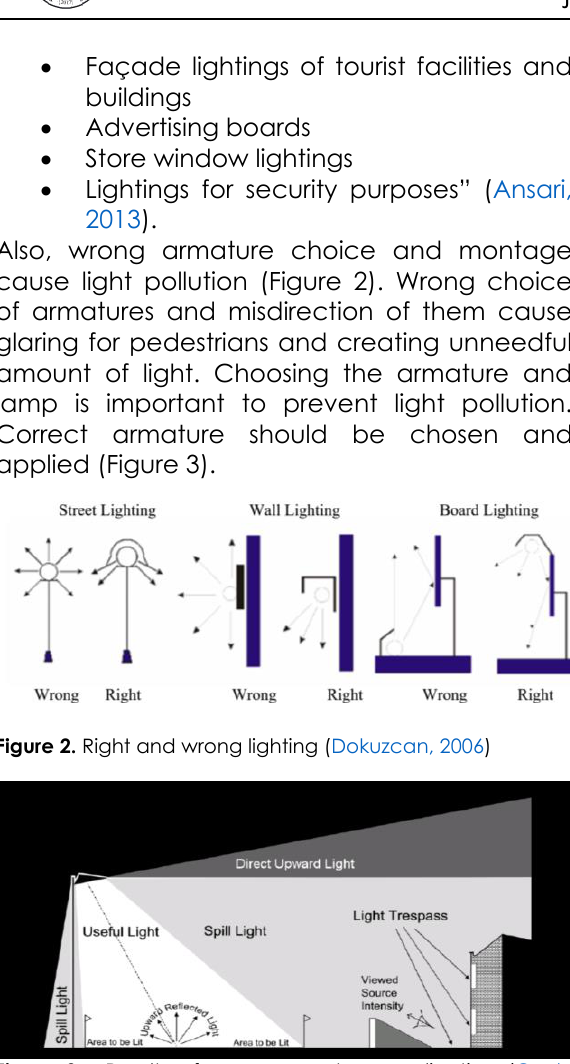
Figure 3. Results of wrong armature application (Onuk,